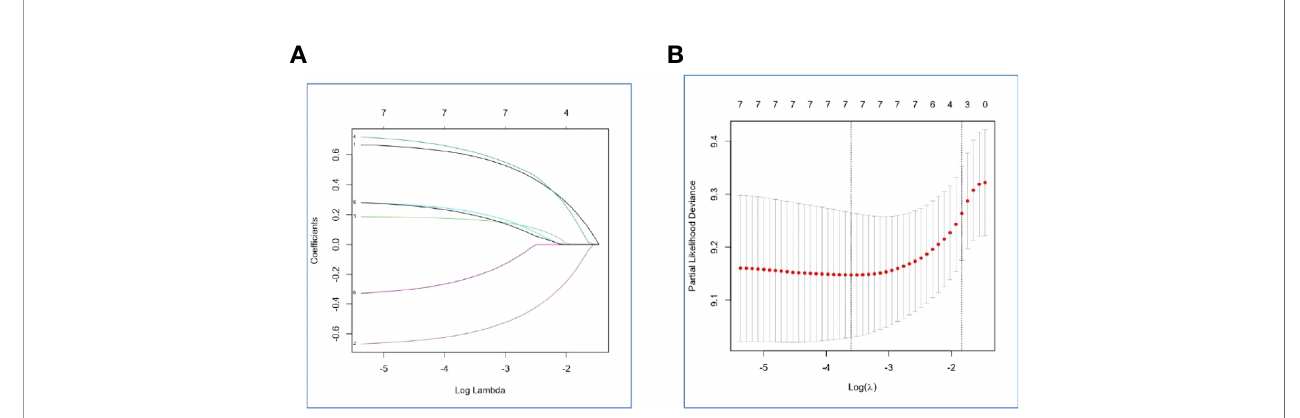
FIGURE 2 | Construction of the Risk-H by the least absolute shrinkage and selection operator (LASSO) model in the internal set. (A) The LASSO-Cox regression model was used to generate the prognostic scoring system named Risk-H. (B) Ten-fold cross-validation for tuning parameter selection in the LASSO model via minimum criteria and 1-SE criteria.